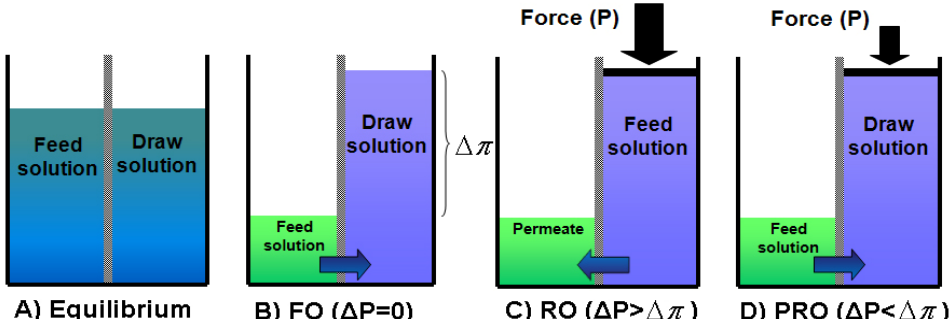
Figure 3. The different classifications of osmotic pressures: ( A ) osmotic equilibrium; ( B ) FO ( Δ P = 0); ( C ) RO ( Δ P > Δπ ) and ( D ) PRO ( Δ P < Δπ ). Illustration adapted from [24]